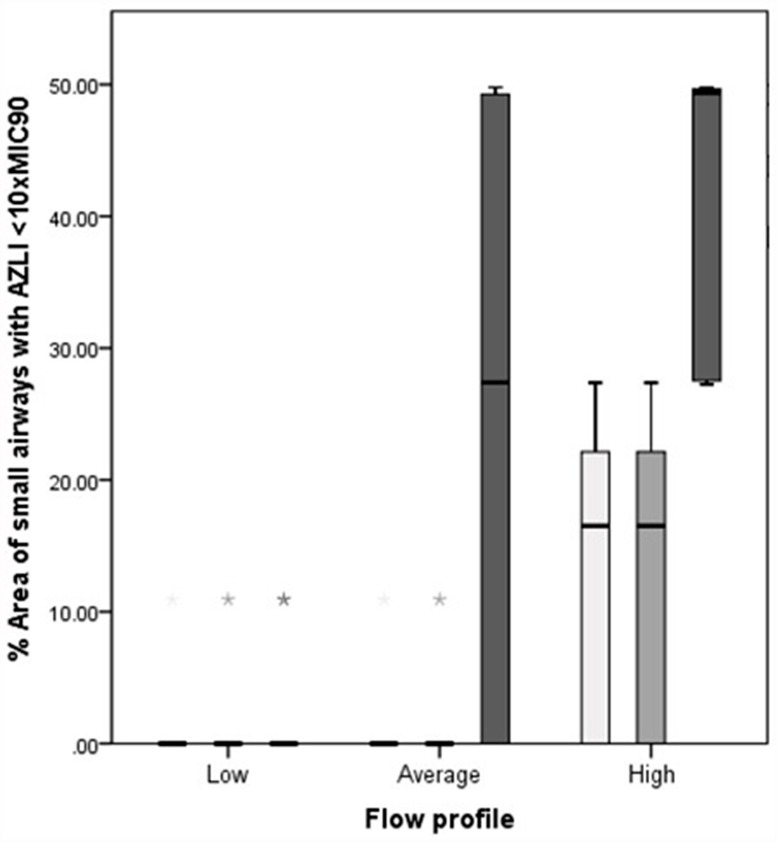
Influence of inhalation technique on AZLI concentrations.Influence of inhalation technique on AZLI concentrations presented as percentage area of small airways with AZLI <10xMIC90. Low breathing profile: tidal volume of 6 ml/kg (228 ml) and respiration rate of 14 breaths/min. Average breathing profile: tidal volume of 10 ml/kg (380 ml) and respiration rate of 18 breaths/min. High breathing profile: tidal volume of 14 ml/kg (532 ml) and respiration rate of 22 breaths/min. Data are presented as median (range) for the different scenarios. Light grey bars represent the scenario of median ASL (5 μm) with largest aerosol diameter (4.35 μm). The darker grey bars represent the scenario of thick ASL (7 μm) with median aerosol diameter (3.18 μm) and the darkest grey bars represent the scenario of thick ASL (7 μm) with largest aerosol diameter (4.35 μm). The scenarios of thin ASL with all diameters, median ASL with smallest and median diameter and thick ASL with smallest diameter are not represented as all breathing profiles resulted in AZLI concentrations above 10xMIC90. ASL = airway surface liquid.